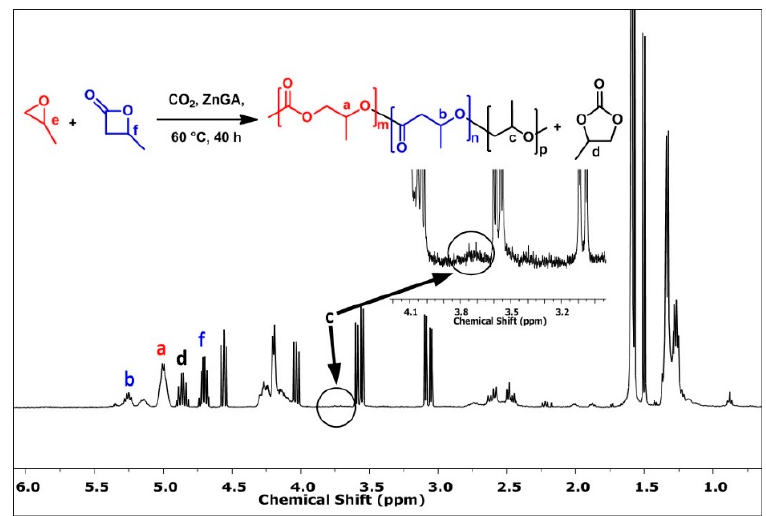
Figure 2. 1 H-NMR spectrum of the mixture of poly(ester-co-carbonate) and cyclic carbonate obtained using the conditions of Entry 1, Table 1.